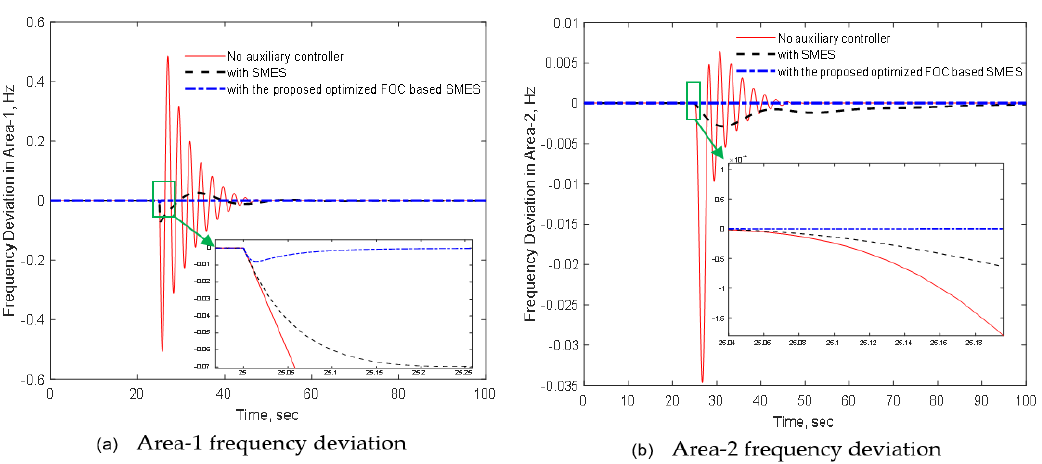
Figure 8. Frequency response for 0.2 p.u. load change in area-1.